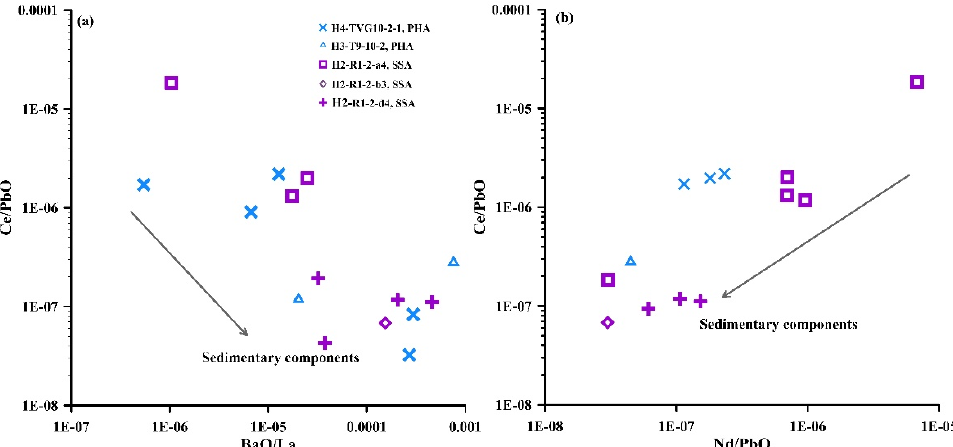
Figure 12. Plots of ( a ) Ce/PbO vs. BaO/La; and ( b ) Ce/PbO vs. Nd/PbO in anglesite minerals from the MOT (samples H2-R1-2-a4, b3, d4) and SOT (samples H3-T9-10-2, H4-TVG10-2-1) hydrothermal fields. PHA—primary hydrothermal anglesite; SSA—secondary supergene anglesite.